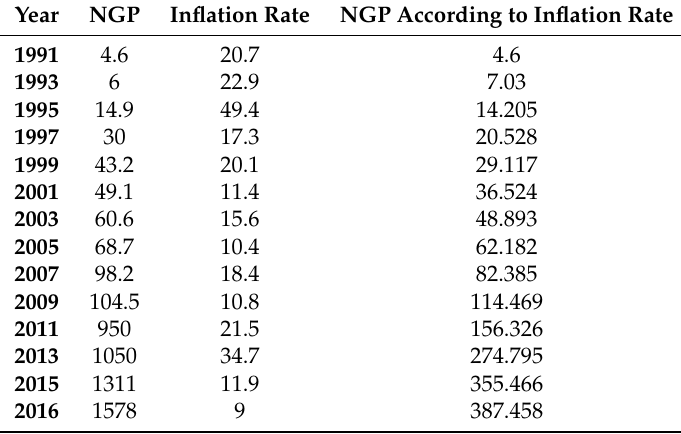
Table 1. Natural gas price and estimated natural gas price according to inflation